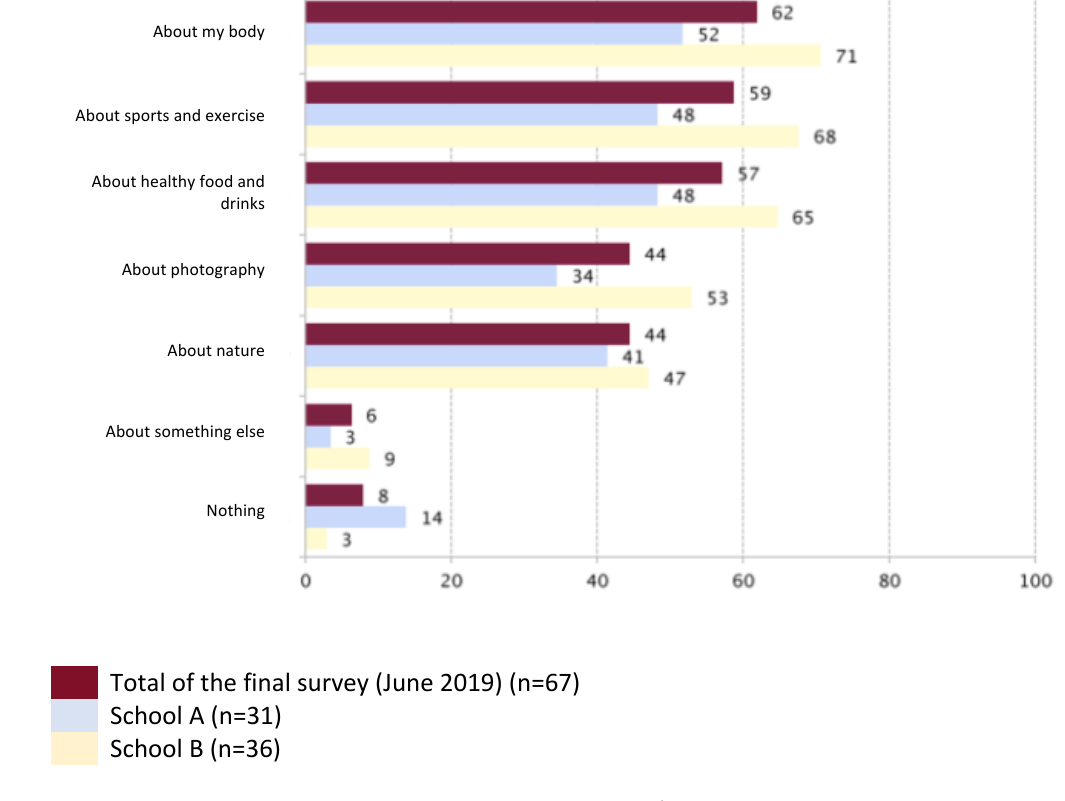
Figure 1. Learning impact of KLIK.